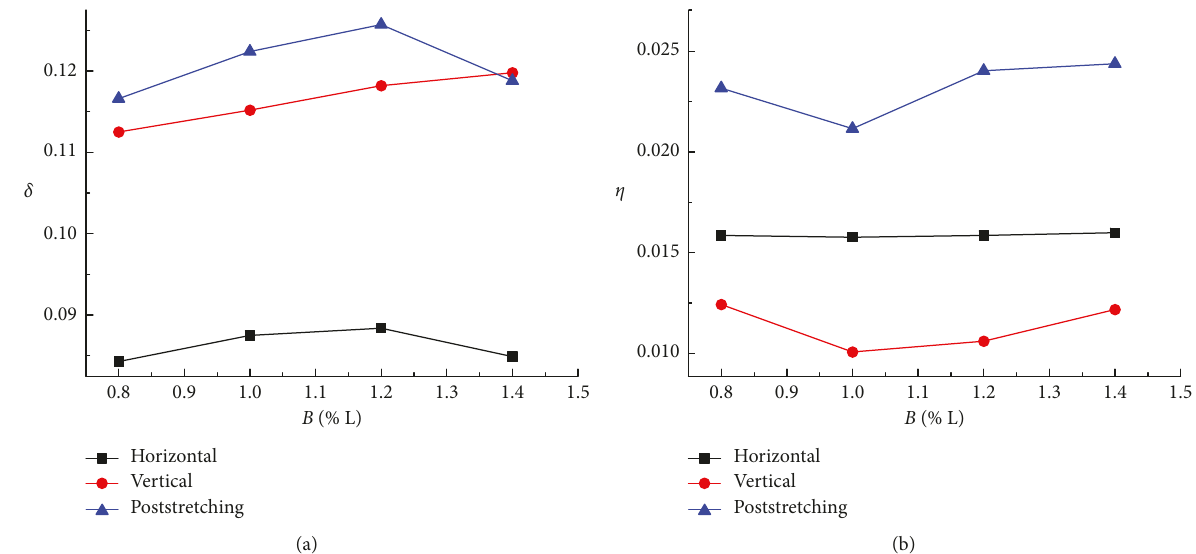
Figure 12: Influence of poststretching on cross-sectional distortion during each